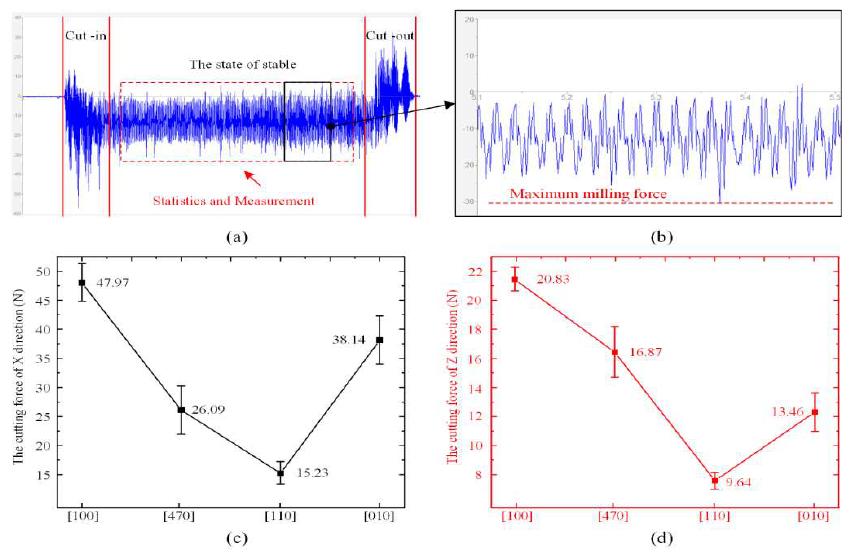
Figure 4. ( a ) Unprocessed cutting force data, ( b ) Maximum milling force, ( c ) the cutting force of X, and ( d ) Z direction.